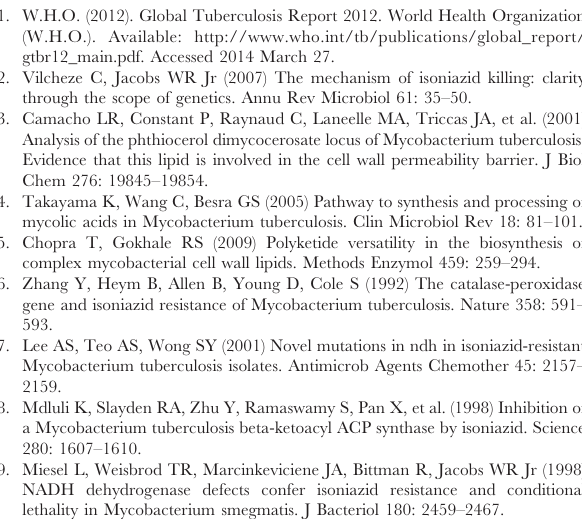
Table S1 List of primers used for PCR amplification and Sanger sequencing. Table S2 List of nonsynonymous and nonsense muta- tions, insertions and deletions identified by whole genome sequencing in INH-resistant isolates. Table S3 List of nonsynonymous, stoploss and stopgain mutations with Poisson distribution p-value , 0.05. Table S4 List of nonsynonymous, stoploss and stopgain mutations with Normal distribution p-value , 0.05. Table S5 List of intergenic mutations with Poisson distribution p-value , 0.05. Table S6 List of intergenic mutations with Normal distribution p-value , 0.05. Table S7 List of mutations verified using Sanger sequencing. Table S8 Drug susceptibility of 101 INH-resistant isolates & 99 INH-susceptible isolates